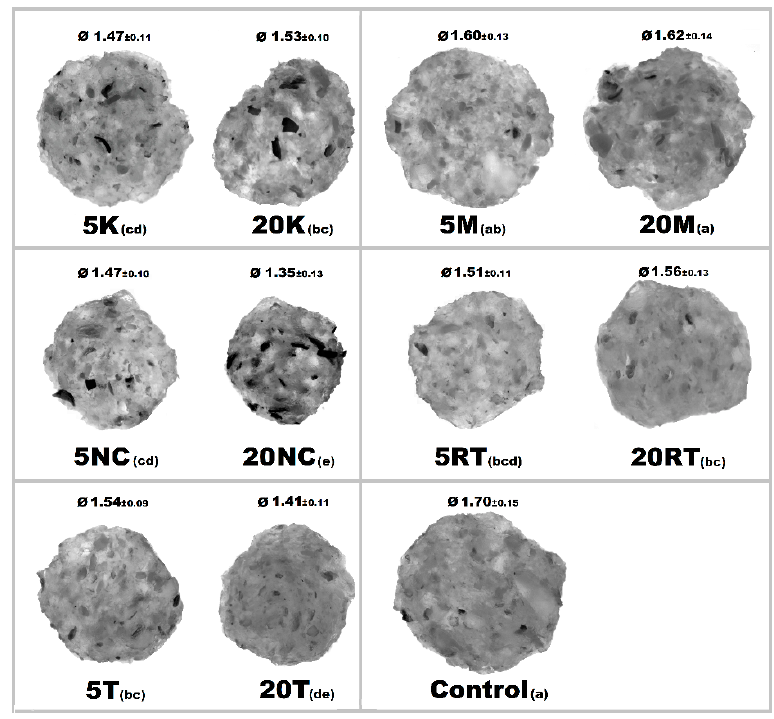
Figure 2. Cross-sectional images of cooked pasta strands containing 5 and 20% quinoa var. kuchivila (5 K, 20 K), mistura (5 M, 20 M), negra collana (5 NC, 20 NC), rosada taraco (5 RT, 20 RT), and titicaca (5 T, 20 T). These samples were obtained under the following conditions. Temperature profile: 87, 100, and 104 °C; Screw speed: 25 rpm; Water content of dough, 55%; Oven drying, 60 °C/2.25 h. Diameter of cooked pasta strands (Ø, mm) and the corresponding SD are shown. Raw data in Suplementary Materials (Table S1). Different letters indicate significant difference at level p of 5%.